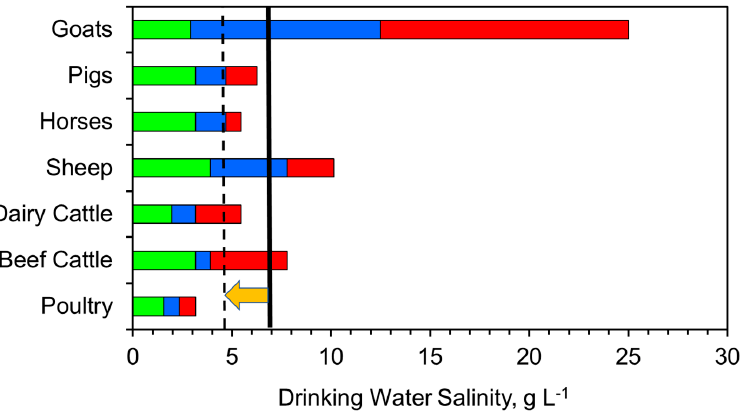
Figure 19 indicates the generic salinity tolerance ranges for a number of different types of animals.